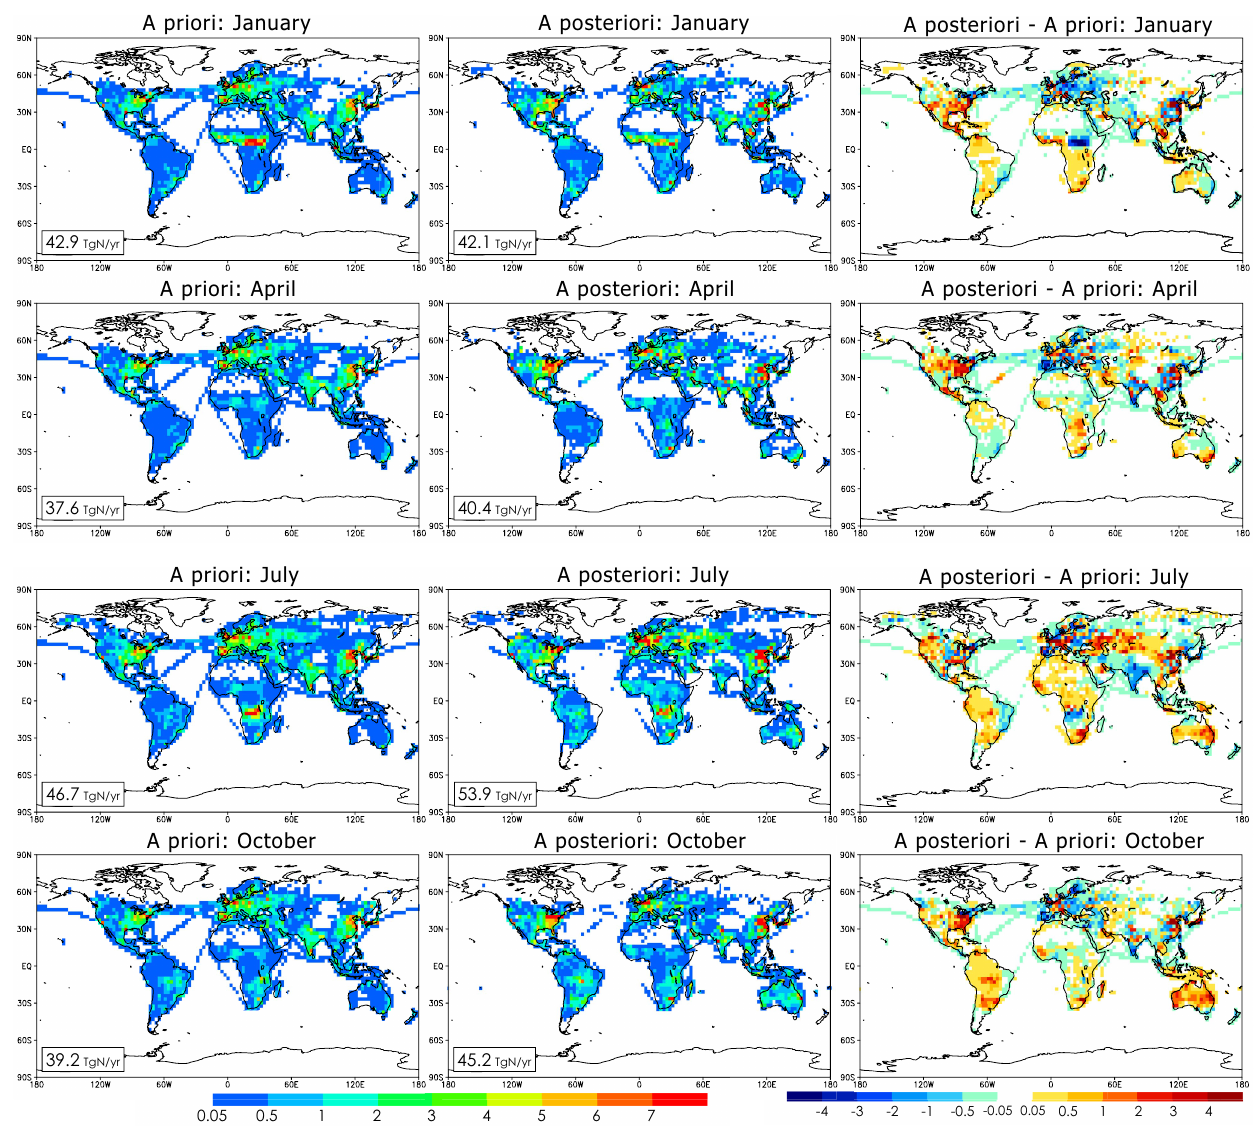
Fig. 6. Global distributions of the surface NO x emissions (in kgm − 2 s − 1 ), averaged over the 16–30th of each month, obtained from the a priori emissions (left columns), the a posteriori emissions (the data assimilation results, center columns), and the difference between them (the a posteriori emissions minus the a priori emissions, right columns) in January, April, July, and October 2005. The red (blue) colour in the left and center panels indicates relatively high (low) values. The red (blue) colour in the right panels indicates that the data assimilation increases (decreases) the surface NO x